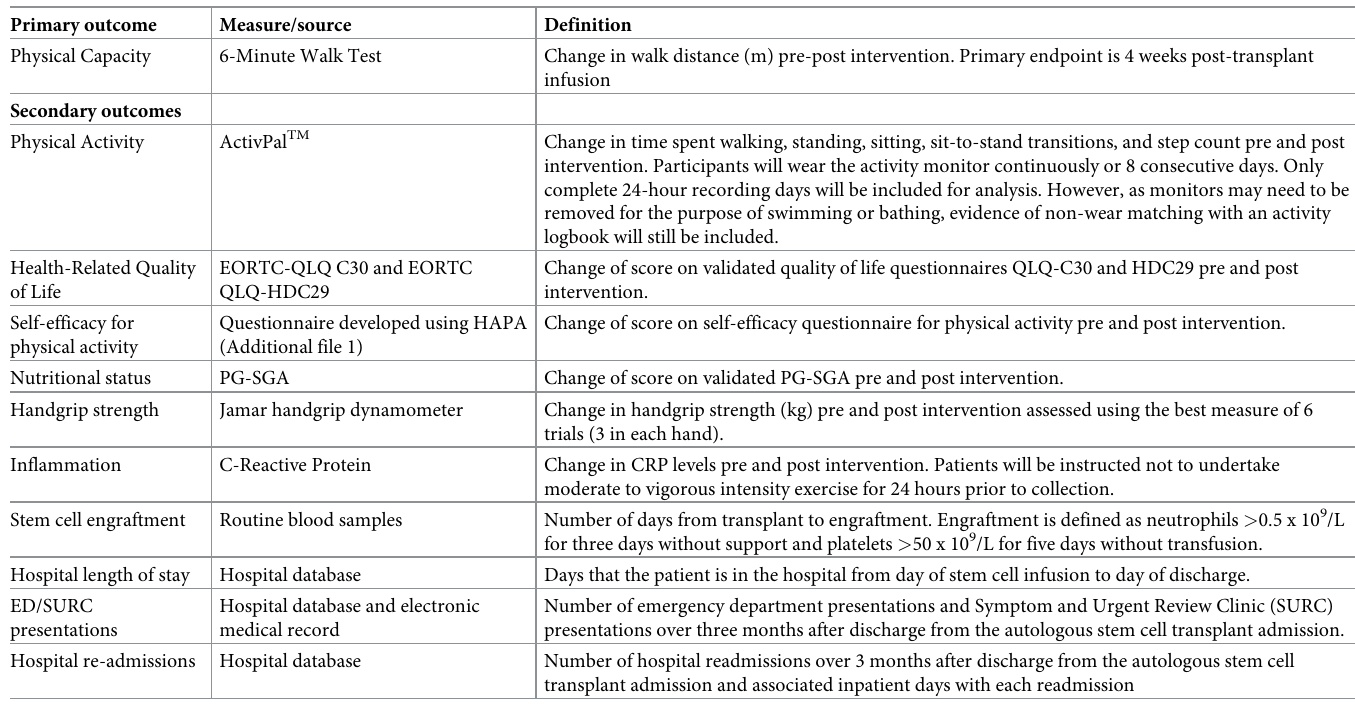
Table 2. Primary and secondary